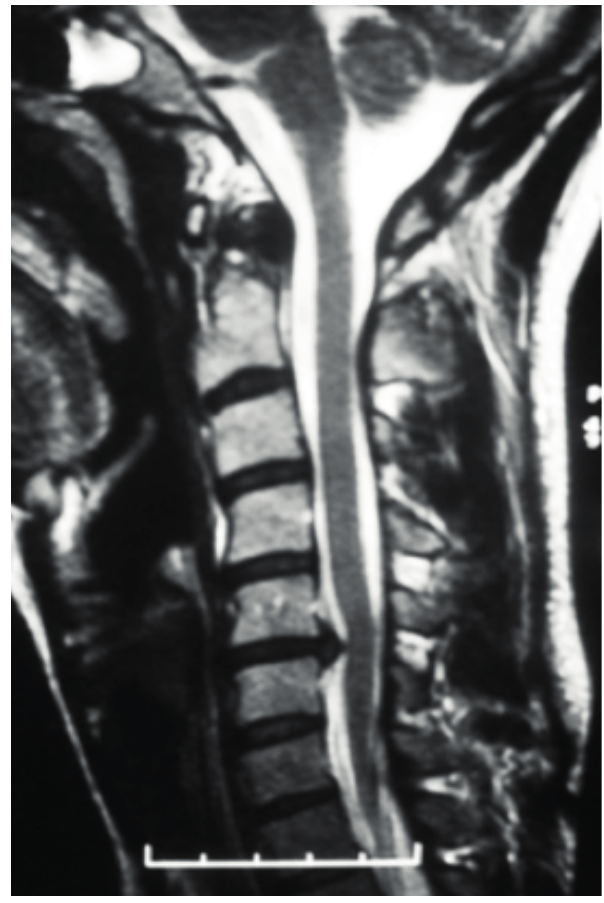
Figure 1 - Case example. Diagnosis of C5-C6 disc herniation in a sagittal T2-MRI image. Patient reported cervical radicu- lopathy